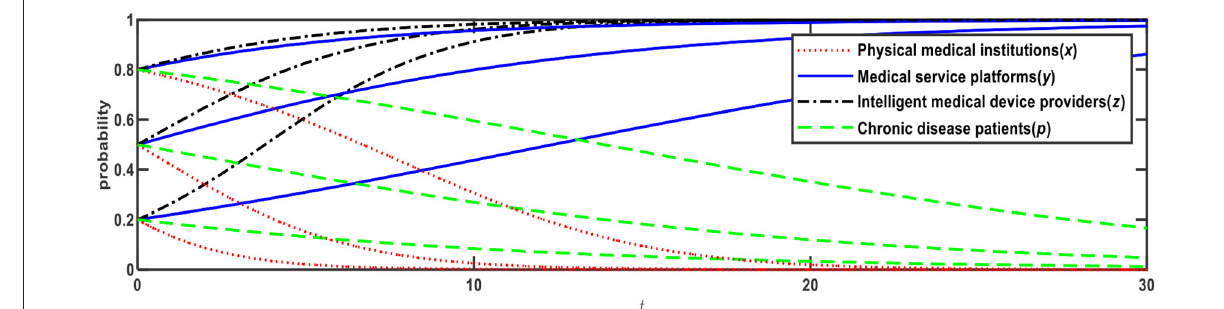
FIGURE6 Evolution of E9 (0,1,1,0).